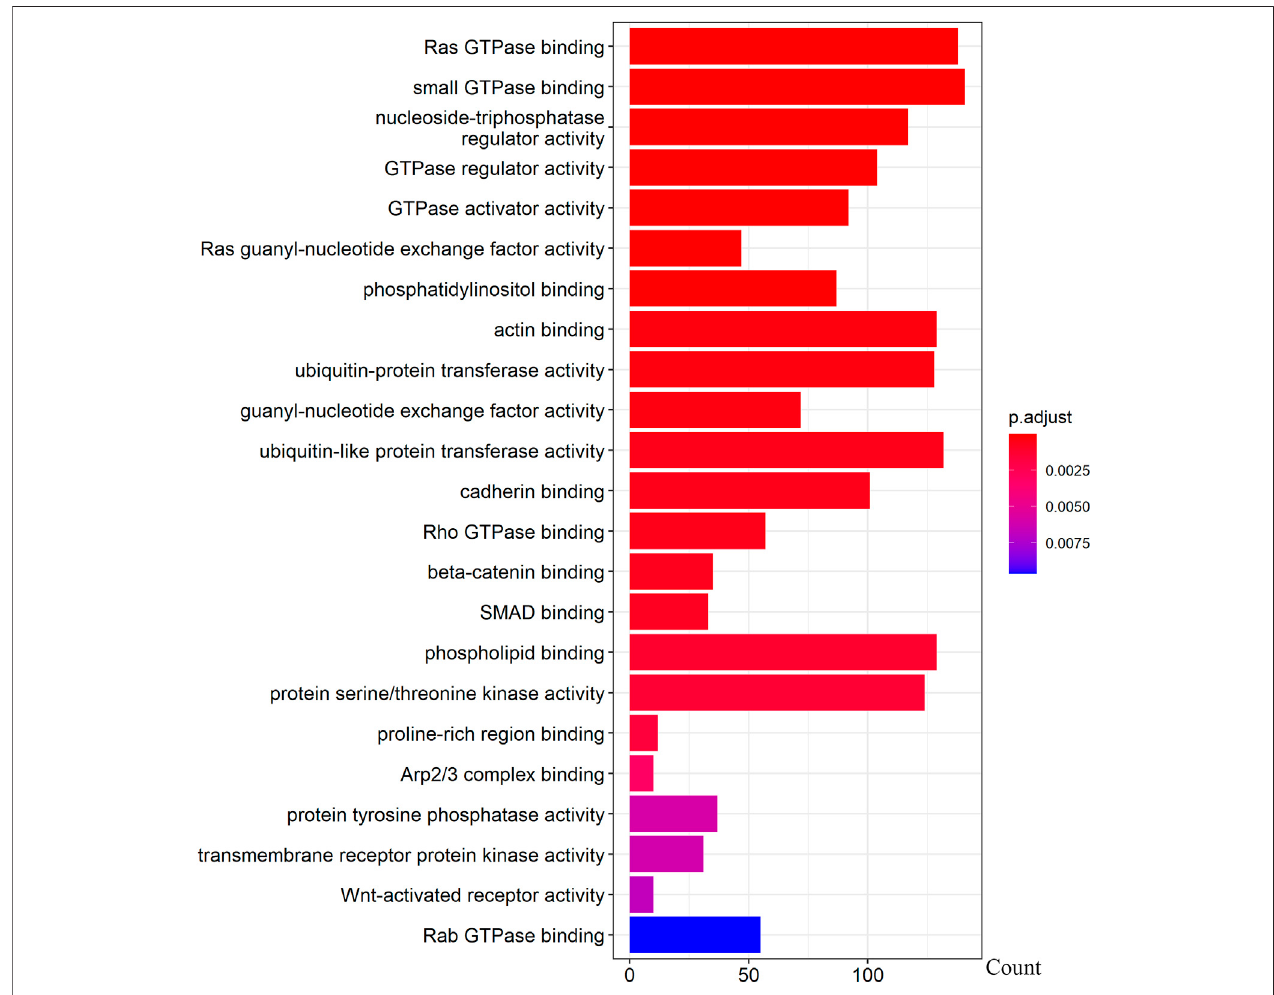
FIGURE 4 | GO analysis of FOXG1-AS1 target genes. Note: The target genes of lncRNAs were identi fi ed from Pearson ’ s correlation analysis (|correlation coef fi cient| > 0.4 and p < 0.001), GO analysis were performed in “ clusterPro fi ler ” and “ org.Hs.eg.db ” of R software to generated these functional pathways.